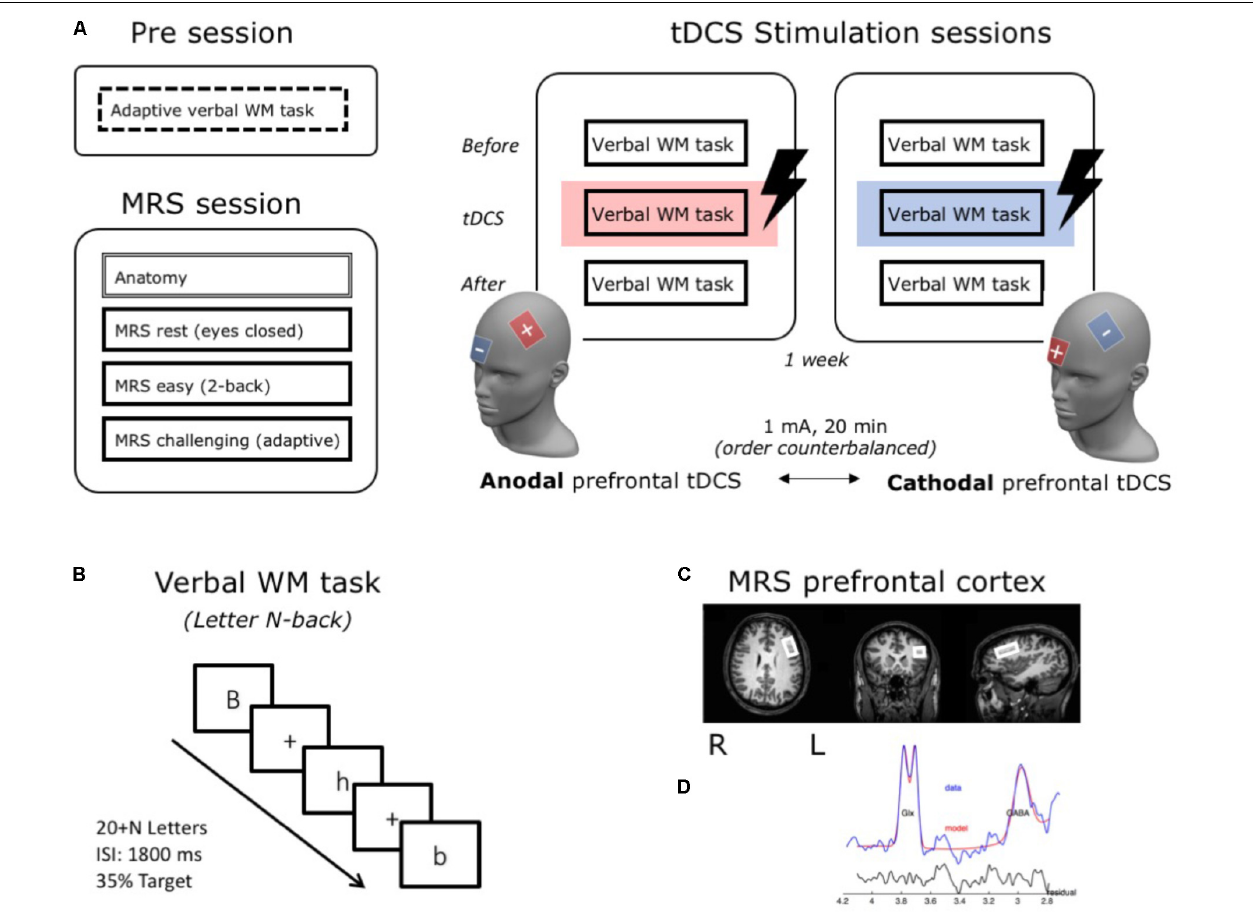
FIGURE 1 | Schematic illustration of the research design and methods. Subjects came to the lab for a total of four sessions (A) . In a first behavioral Pre session, WM updating capacity (individual N) was determined for each participant using an adaptive version of the verbal WM updating task. In a second MRS-session, 3T-MRS was used to measure individual GABA and Glutamate concentrations in the left DLPFC under three conditions: rest, an easy and a challenging WM task. Notably, because we observed no differences between these three conditions [as reported in Talsma et al. (submitted)], for this study we averaged over all conditions and calculated Glutamate/GABA ratios to use as a measure for prefrontal cortical excitability. In two subsequent stimulation sessions, participants performed three blocks of a verbal WM task. During the second block, they received either anodal or cathodal stimulation over the lDLPFC (active electrode – F3, reference – above the right eye). (B) In the verbal WM task (letter N-back), a stream of letters was presented and participants were required to press a button if the current letter was the same as N stimuli before. In the adaptive version in the Pre session, the level of N was on-line adjusted to performance and gave us a measure for individual updating capacity for each subject (individual N). For the stimulation sessions, level of N consequently ranged between –1 and +2 around this individual updating capacity level to ensure a challenging task level for all subjects. (C) MRS-voxel location over the lDLPFC (size: 30 mm × 20 mm × 25 mm). (D) Modeling of the GABA and Glx (Glutamate + Glutamine) signal for a typical subject [output from the Gannet toolbox (www.gabamrs.com)]. In blue the edited spectrum is shown, overlaid in red is the model of best fit (using a simple Gaussian model) and the residual of these is shown in black.